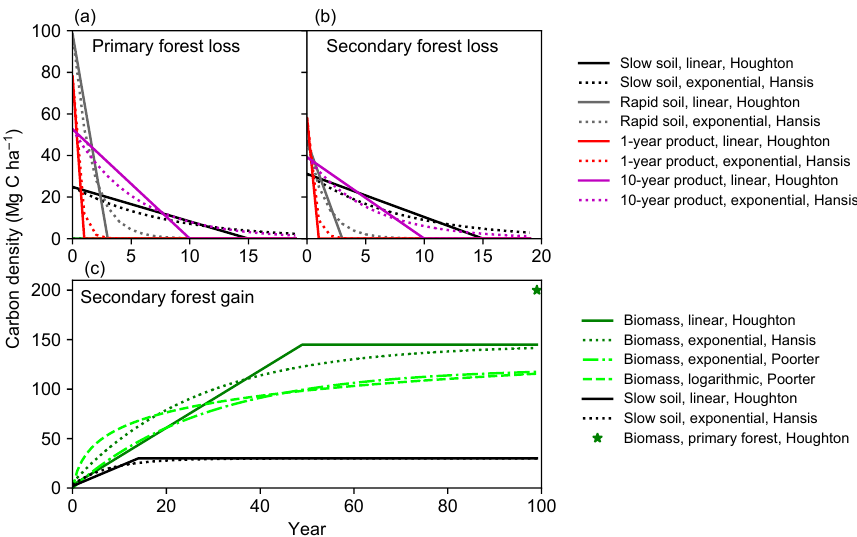
Figure 1. Response curves for tropical moist forest in bookkeeping models and from a recent field study. Solid and dotted lines indicate the linear (Houghton, 1999) and exponential (Hansis et al., 2015) curves respectively. Lime dashed and dash-dotted lines are the logarithmic and exponential curves from forest plots (Poorter et al., 2016). Vegetation carbon density in primary forest (Houghton, 1999) is also shown as a star in panel (c) for comparison.